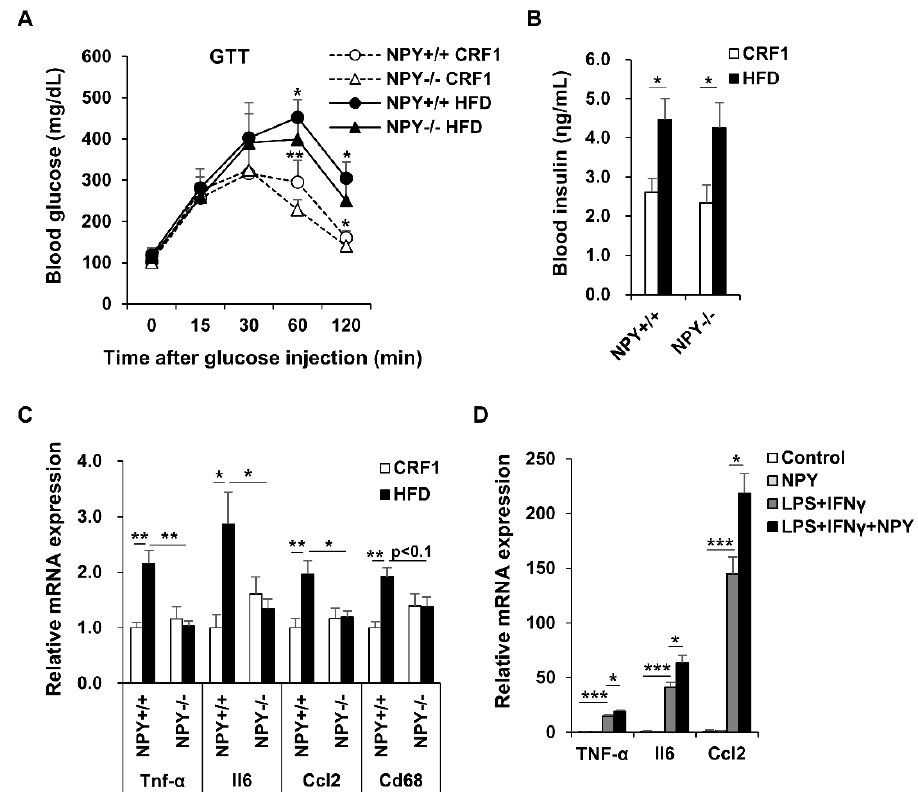
Figure 3. NPY deficiency inhibits inflammation and glucose intolerance. ( A ) (GTT), ( B ) Insulin, ( C ) mRNA expression level of pro-inflammatory gene expression in eWAT from WT and KO mice ( n = 6–12 per group), ( D ) Effect of NPY on Lipopolysaccharide (LPS) and Interferon gamma (IFN γ )-induced pro-inflammatory gene expression in Raw264.7 cells ( n = 4 per group). Raw264.7 cells were incubated with 100 nM NPY in the presence or absence of 10 ng/mL LPS and 10 ng/mL INFγ for 24 h. All data are presented as the mean ± SEM, Student’s two-tailed t test, * p < 0.05, ** p < 0.01, and *** p < 0.001.